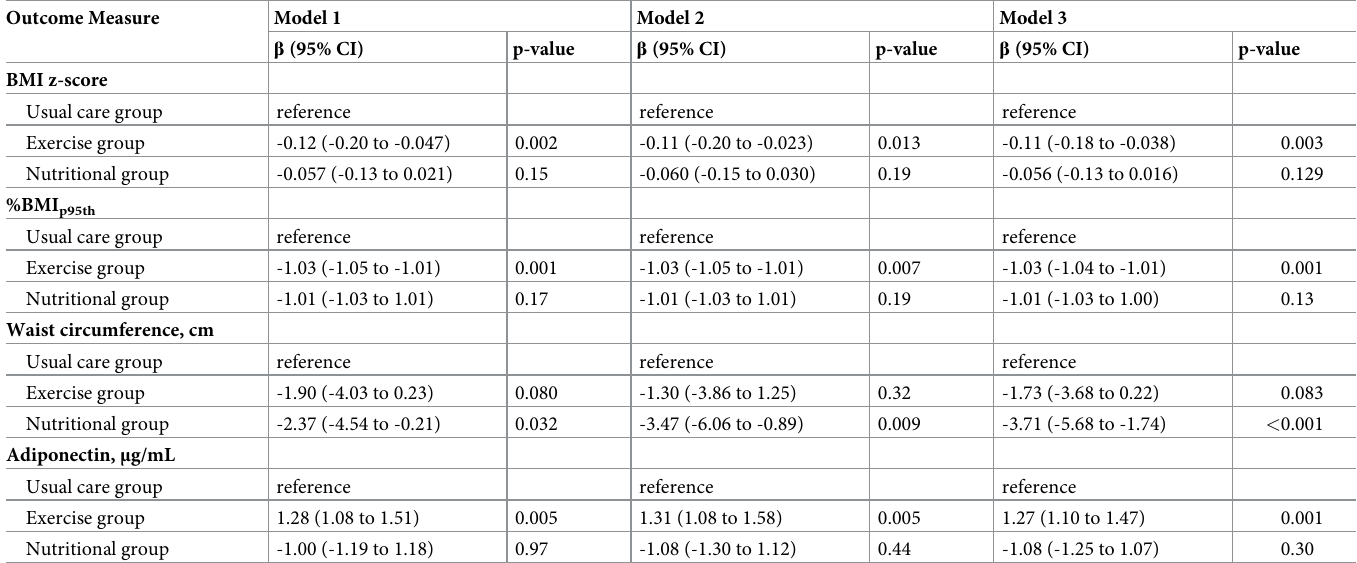
Table 5. Between-group differences in outcomes over